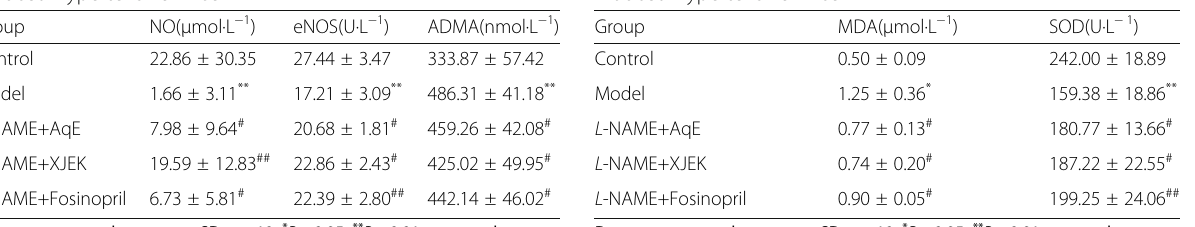
Table 5 Effects of AqE on SOD and MDA content in L